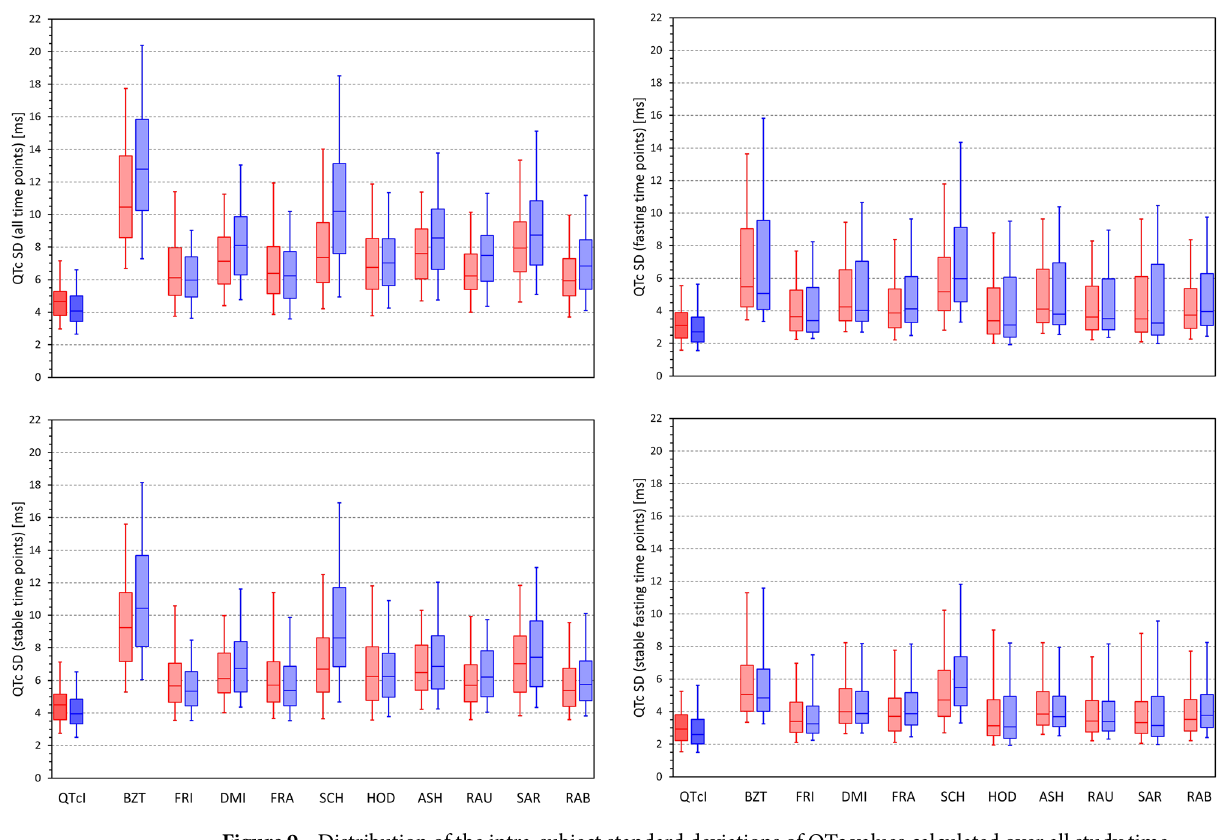
Figure 9. Distribution of the intra-subject standard deviations of QTc values calculated over all study time- points (top left panel), time-points with stable heart rate (bottom left panel), morning fasting time-points (top right panel), and morning fasting time-points with stable heart rate (bottom right panel). The layout of the panels and the meaning of the box and whisker graphs is the same as in Fig. 8. ms milliseconds, SD standard deviation.